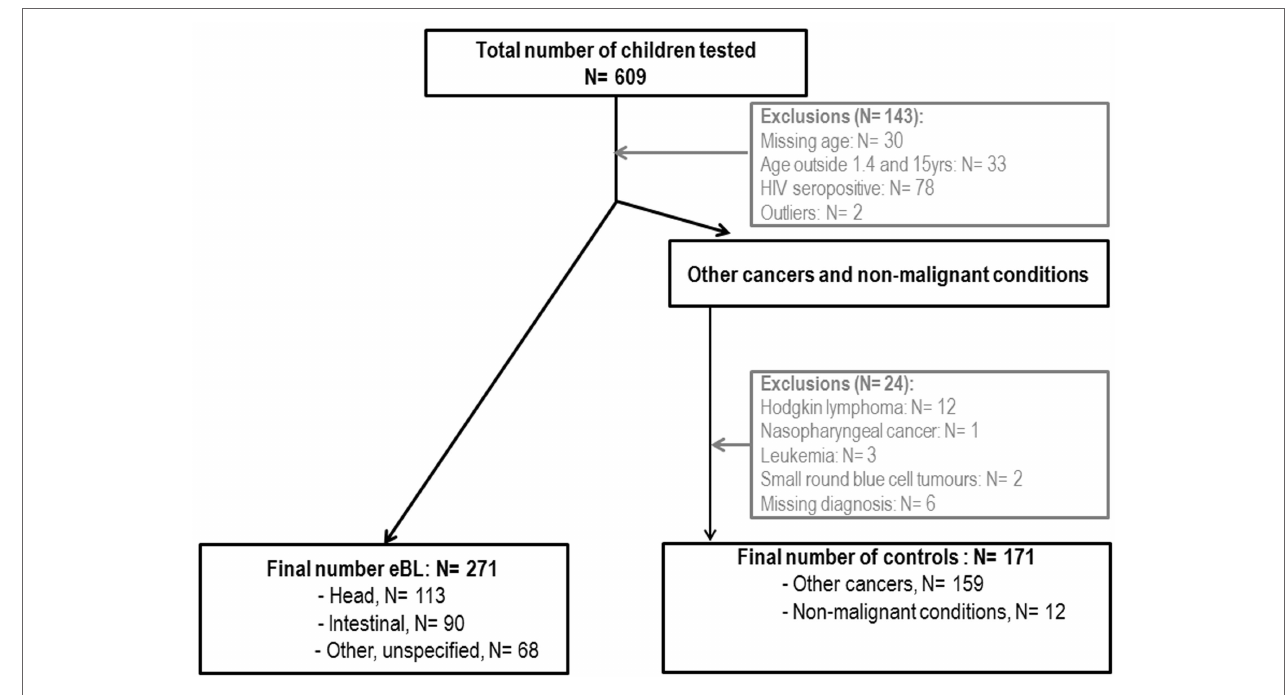
FigUre 1 | Flowchart of endemic Burkitt lymphoma (eBL) cases and controls included in the